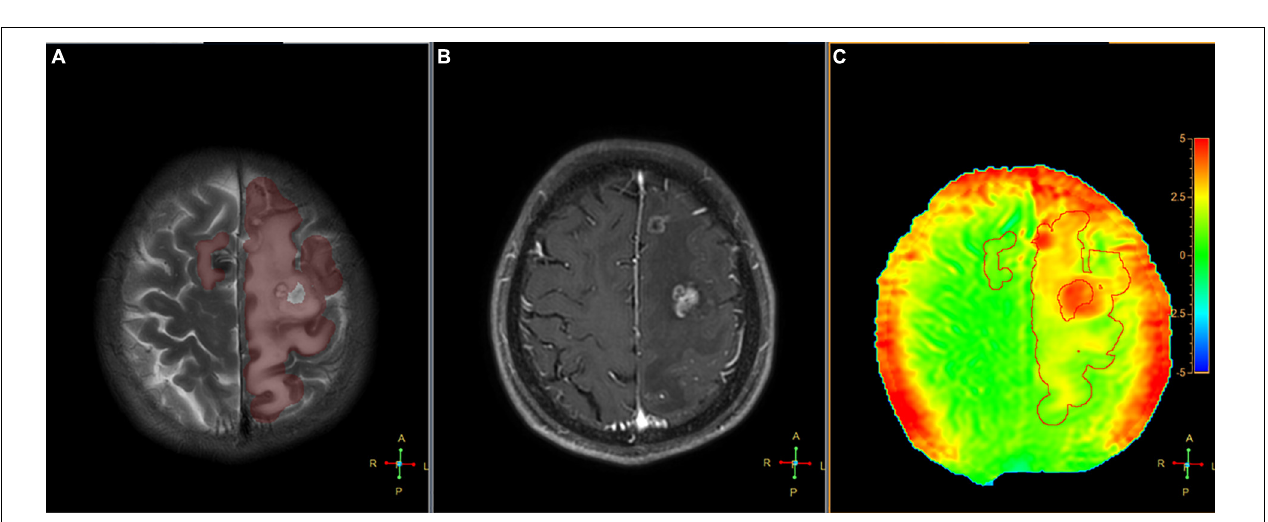
FIGURE 6 | Segmented peritumoral high signal intensity areas and the peritumoral areas in a 45-year-old male with a metastasis (the primary site of cancer was lung) overlaid onto coregistered T2W (A) , Gd-T1W (B) , and APTw (C) images (SENSE AF = 1.6). The APT edema was 2.54%.